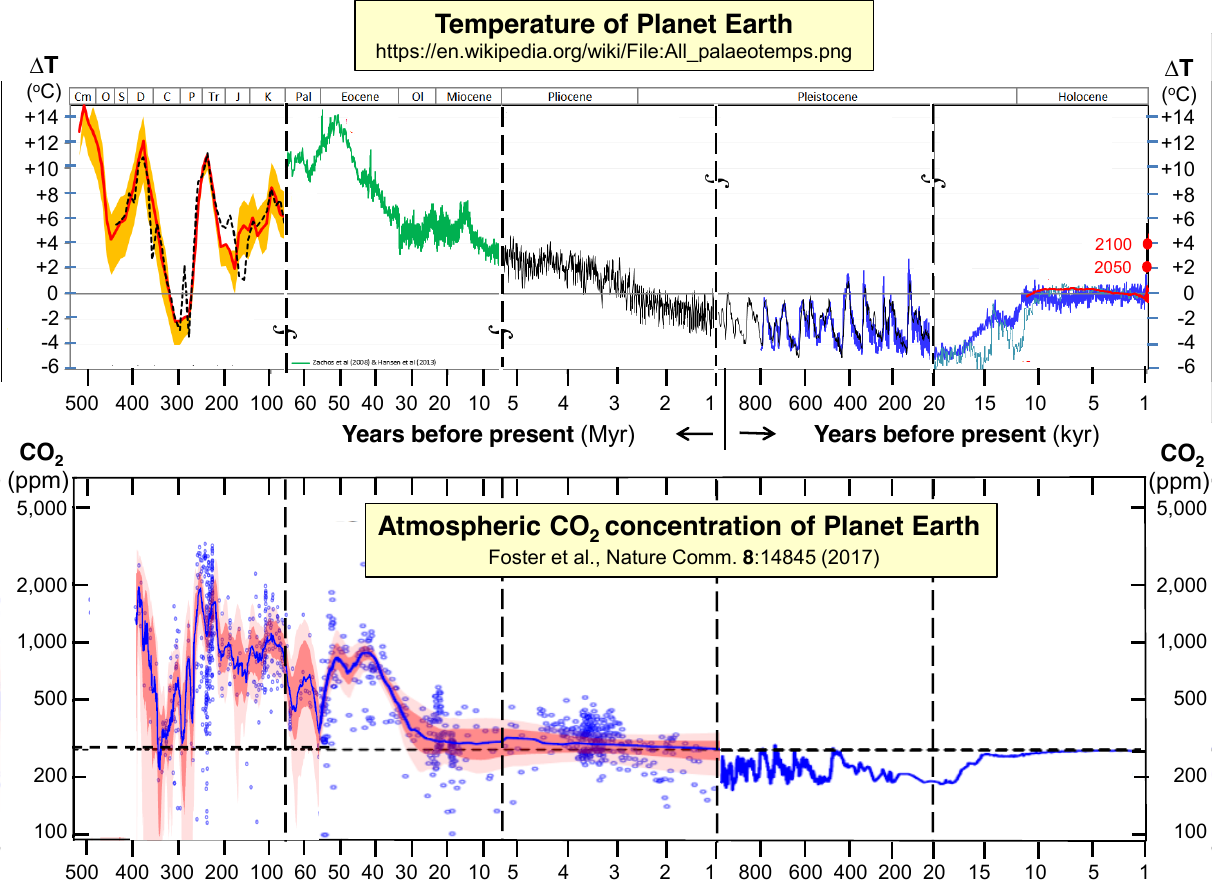
Figure 1. Summary of temperature and CO 2 concentrations on Earth for the last 500 million years. The figure is a composite from the original temperature record [34] and the CO 2 record [35]. The CO 2 record was adjusted to the same time scale as the temperature record. Possible temperature increase in 2050 and 2100, respectively, predicted by some climate models are indicated with red dots on the rightmost temperature